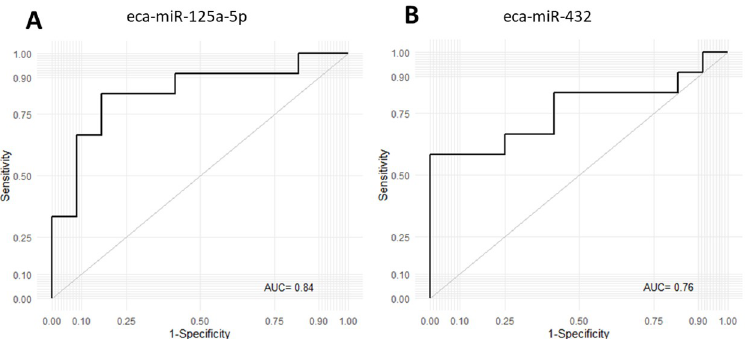
Fig 5. ROC curve analyses assessing whole blood expression of eca-miR-125a-5p (A) and eca-miR-432 (B) for discrimination of male horses, that developed ES lesions throughout the study period (male NO) and horses, that remained tumor-free (male CTL). Abbreviations: ROC = Receiver Operating Characteristic. AUC = Area Under the Curve, NO = new occurrence, CTL = control, ES = equine sarcoid.